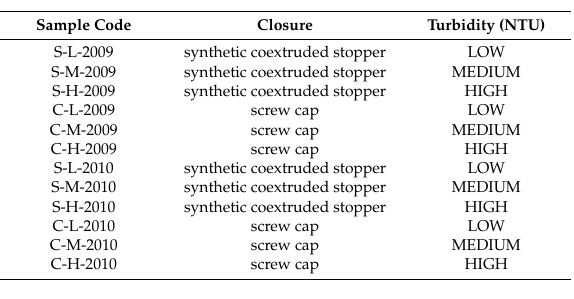
Table 1. Characteristics of the white wines used in this study and their